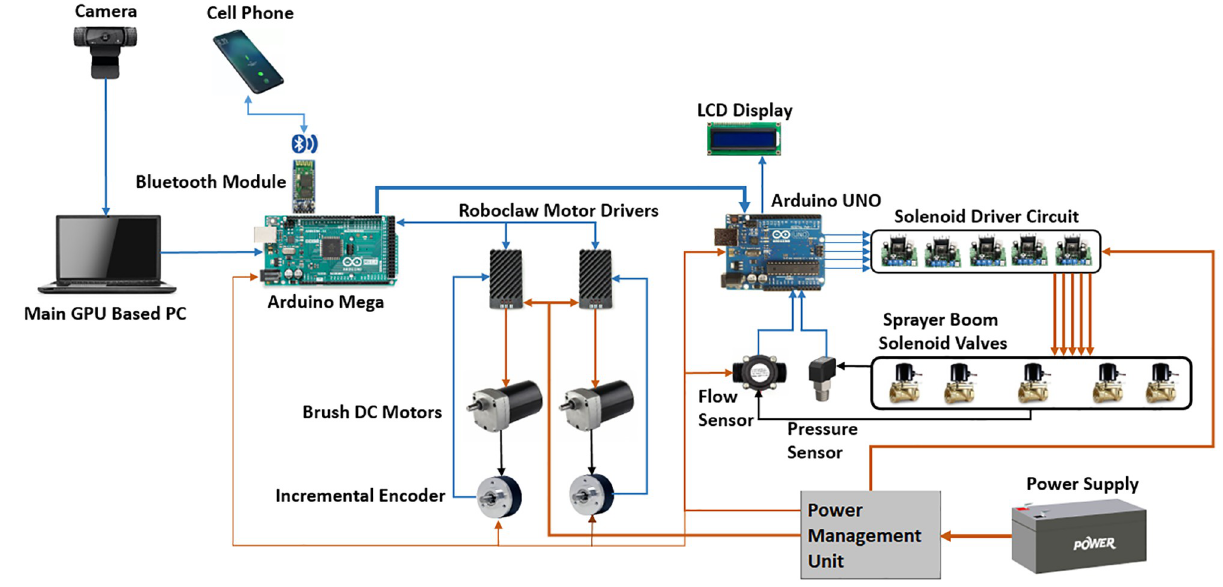
Fig 1. System architecture of precision agricultural spraying